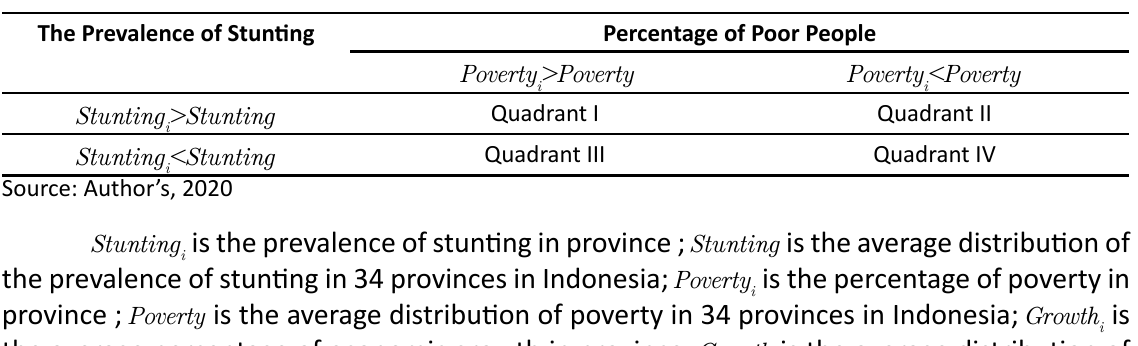
Table 1: Analysis of the Klassen Typology Approach Between Prevalence of Stunting and Percentage of Poor